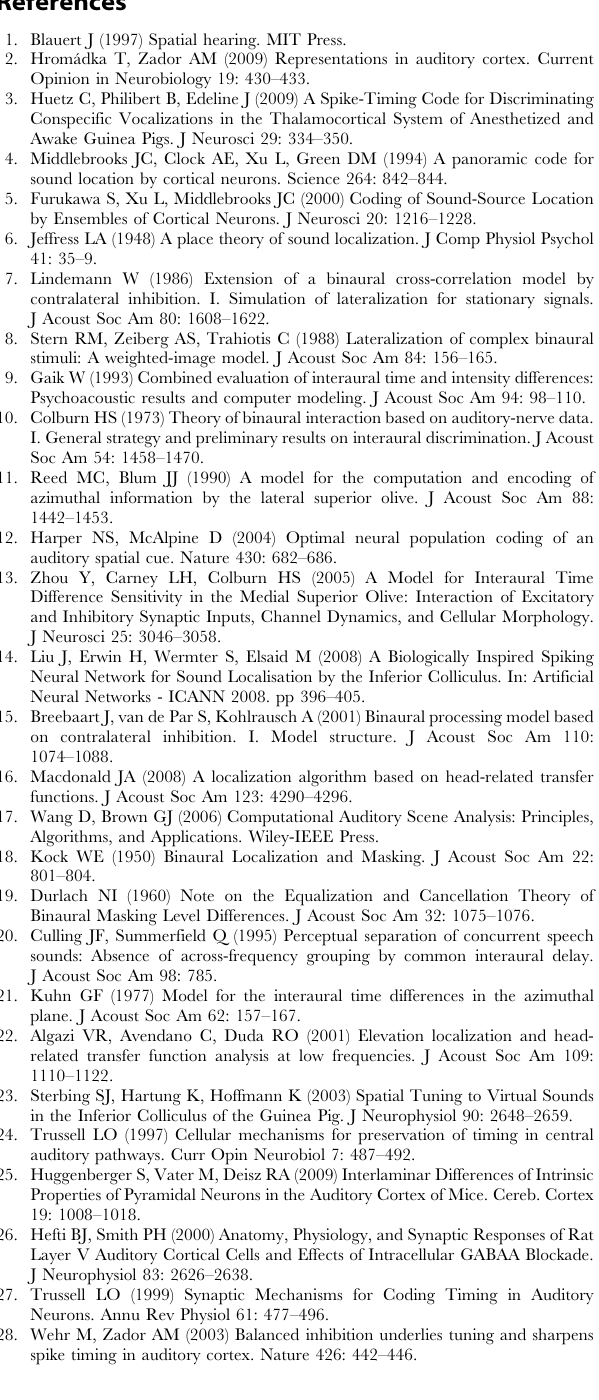
filtering is restricted to bandpass-filtering and delays (no gains; top row) or gains (no delays; bottom row). Colors and lines follow the same conventions as in Figure 6. In both cases, performance is significantly worse. (A,D) Error in azimuth. (B,E) Error in elevation. (C,F) Categorization performance (as in Figure 6). Figure S4 Performance of approximate model when delays are constrained in the p -limit. Performance of approximate model when delays are constrained in the p -limit: in each band with central frequency f, all delays are replaced by delays between 2 1/